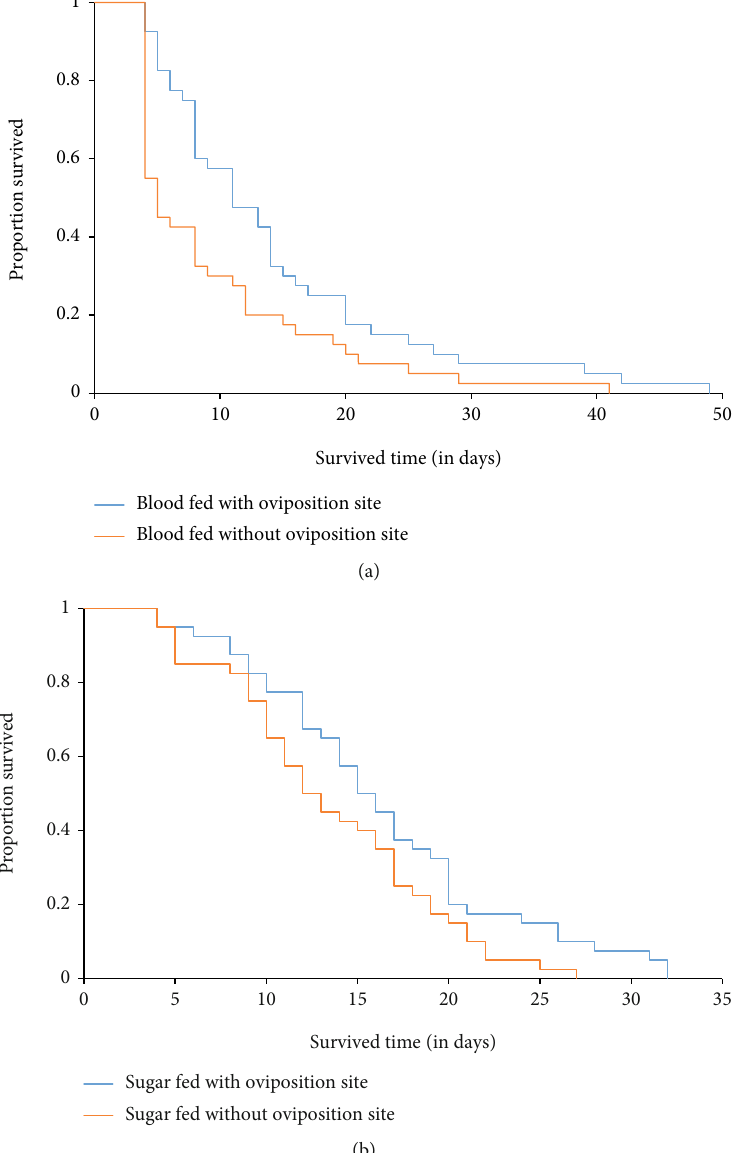
Figure 3: (a) Kaplan-Meier survival curve of adult An. gambiae s.s. fed on blood alone provided and deprived oviposition site. (b) Kaplan- Meier survival curve of adult An. gambiae s.s. fed on sugar alone provided and deprived oviposition